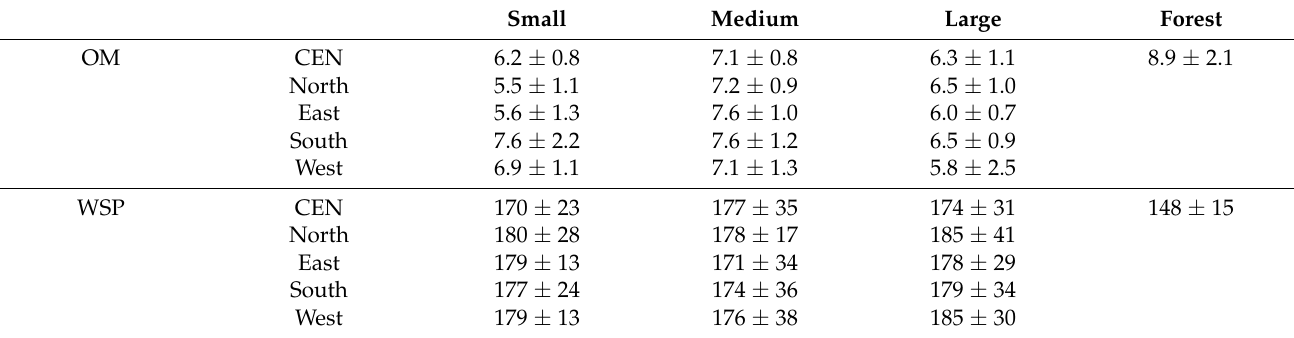
Table 2. Chemical and biochemical soil properties in each gap size for each cardinal point, in center of gap (CEN) and in forest. Organic matter (OM, %), water soluble phenols (WSP, µ g TAE g − 1 d.s), ammonium-nitrogen (N-NH 4+ , mg kg − 1 d.s), carbon nitrogen ratio (C/N), fluorescein diacetate hydrolase (FDA, µ g fluorescein released g − 1 ds), dehydrogenase (DHA,